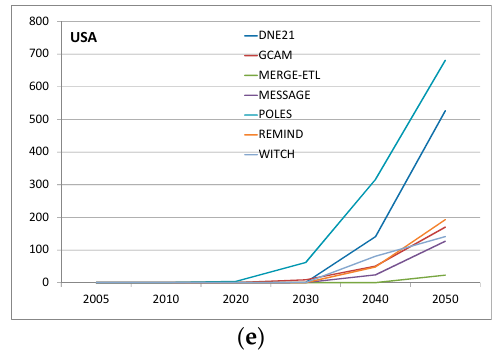
Figure B4. Inter-model comparison of installed capacity (GW) for coal and gas CC in ( a ) World (2030– 2050 growth rate = 7%–17% p.a.); ( b ) China (2030–2050 growth rate = 0–15% p.a.); ( c ) The EU (2030– 2050 growth rate = 6%–15% p.a.); ( d ) India (2030–2050 growth rate = 6%–22% p.a.) and ( e ) USA (2030– 2050 growth rate = 6%–18% p.a.).